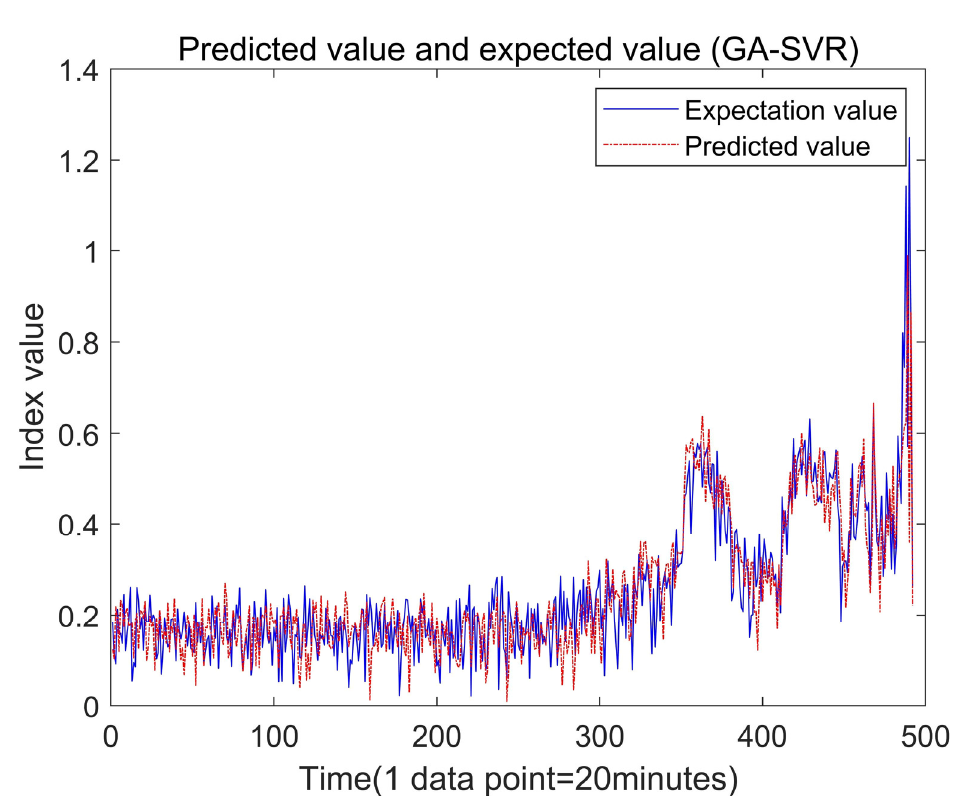
Figure 10. The regression prediction analysis of the test set by